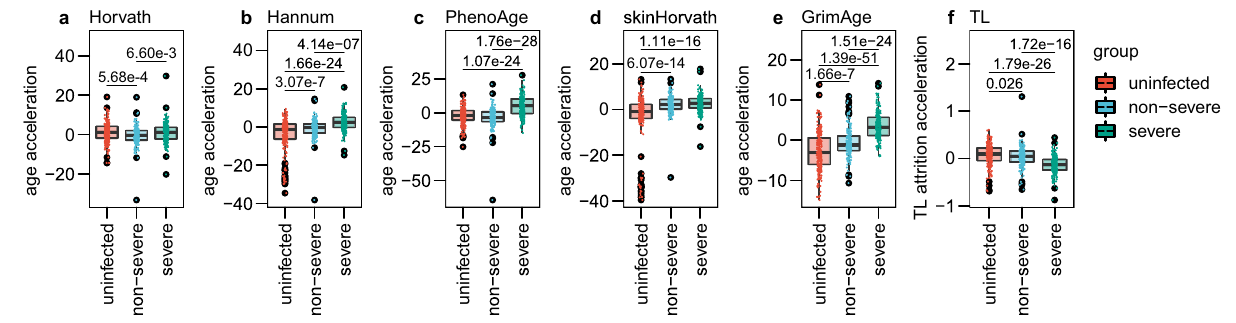
Fig. 2 Accelerated epigenetic aging in non-severe and severe COVID-19 patients. Distribution of DNAm age acceleration ( a – e , fi ve epigenetic clocks) and telomere attrition acceleration ( f , TL) in the peripheral blood from 232 healthy individuals, 194 non-severe and 213 severe COVID-19 patients. The y-axis shows the epigenetic age acceleration after adjusting for cell-type fractions (i.e., residual of regressing the epigenetic age acceleration on cell-type fractions). The p value for each t-test is shown above the corresponding line. In the box plots, the lower and upper hinges indicate the 25th and 75th percentiles, and the black line within the box marks the median value. The whiskers extend from the hinges to the largest and smallest values no further than 1.5× inter-quartile range from the hinges, and the points beyond the end of whiskers indicate outliers. Source data are provided as a Source Data fi le.